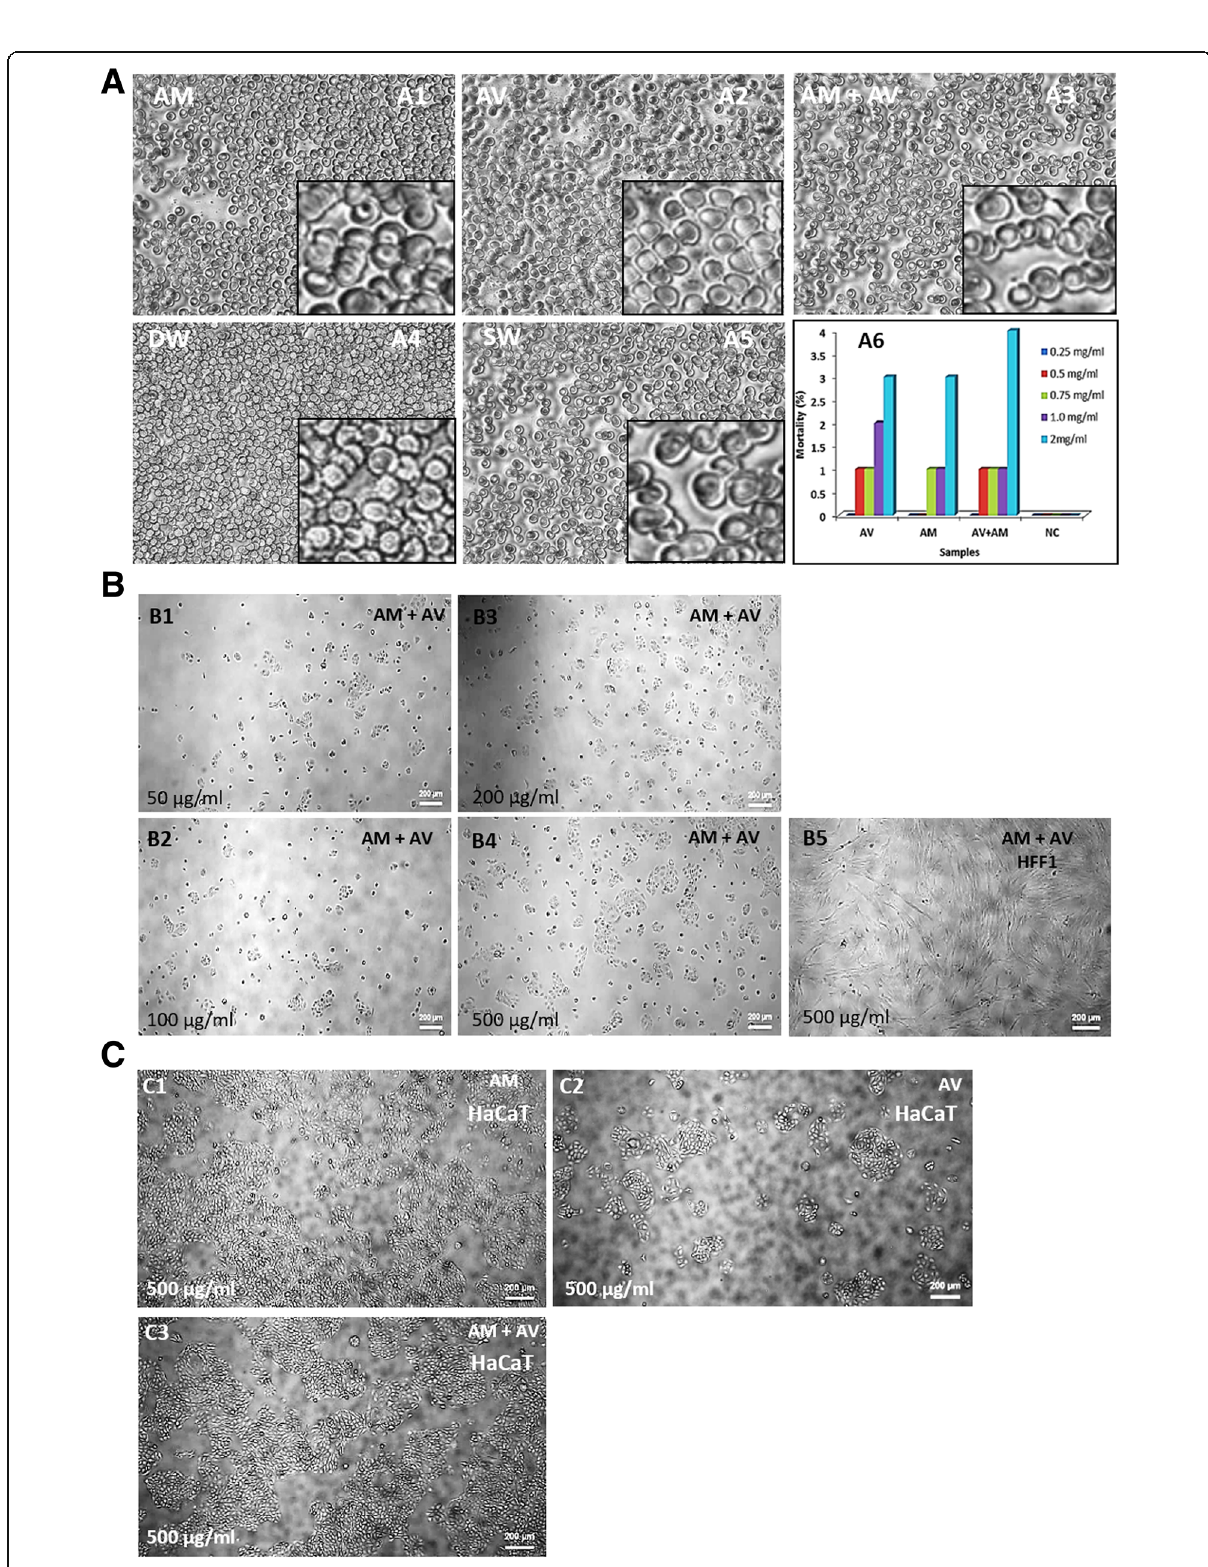
Fig. 2 Heparinized human blood biocompatibility ( a ), brine shrimp lethality bioassay (a6); HaCaT and HFF1 cells compatibility with gels ( b and c ). RBC morphology of heparinized blood incubated with AM (a1), AV (a2), AM+AV (a3), DW (a4) and SW (a5). a6 diagram shows the mortality percentages of brine shrimp ( A. salina ). 500 μ g/mL was shown to be suitable for HaCaT and HFF1 cells in vitro ( b and c